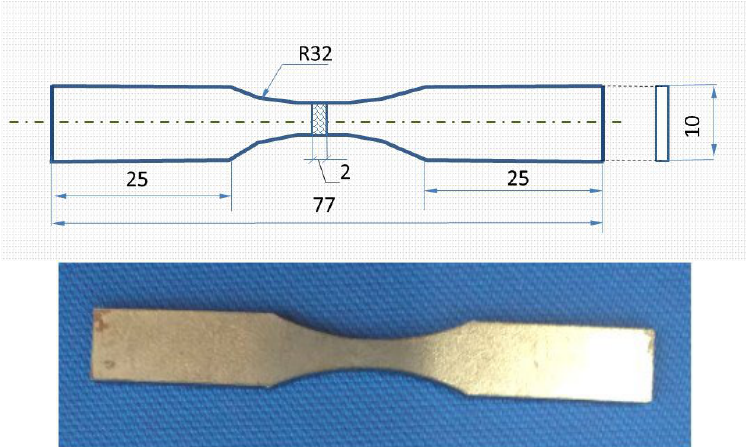
Figure 1. Sample for fatigue test measurements and view of the sample (own research).